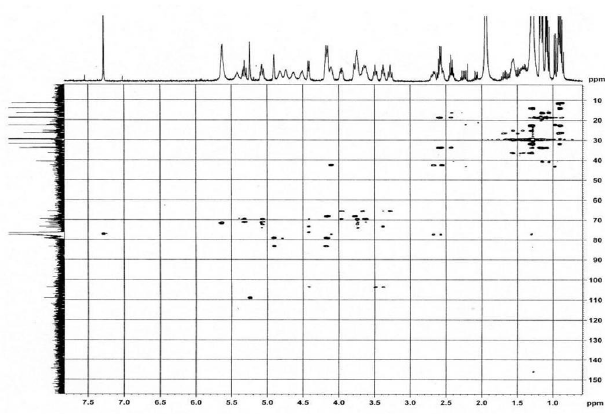
Fig 3 . HSQC-TOCSY NMR of the major sugar ester compound isolated from S. bistellatum.